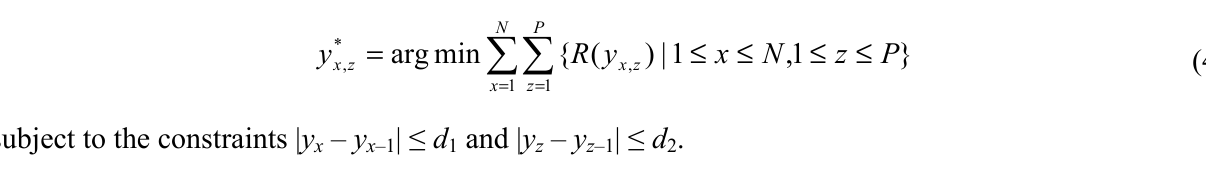
Figure 1. The 3D matrix R contains the feature of an image sequence. The structure of the accumulation matrices ( a ) C